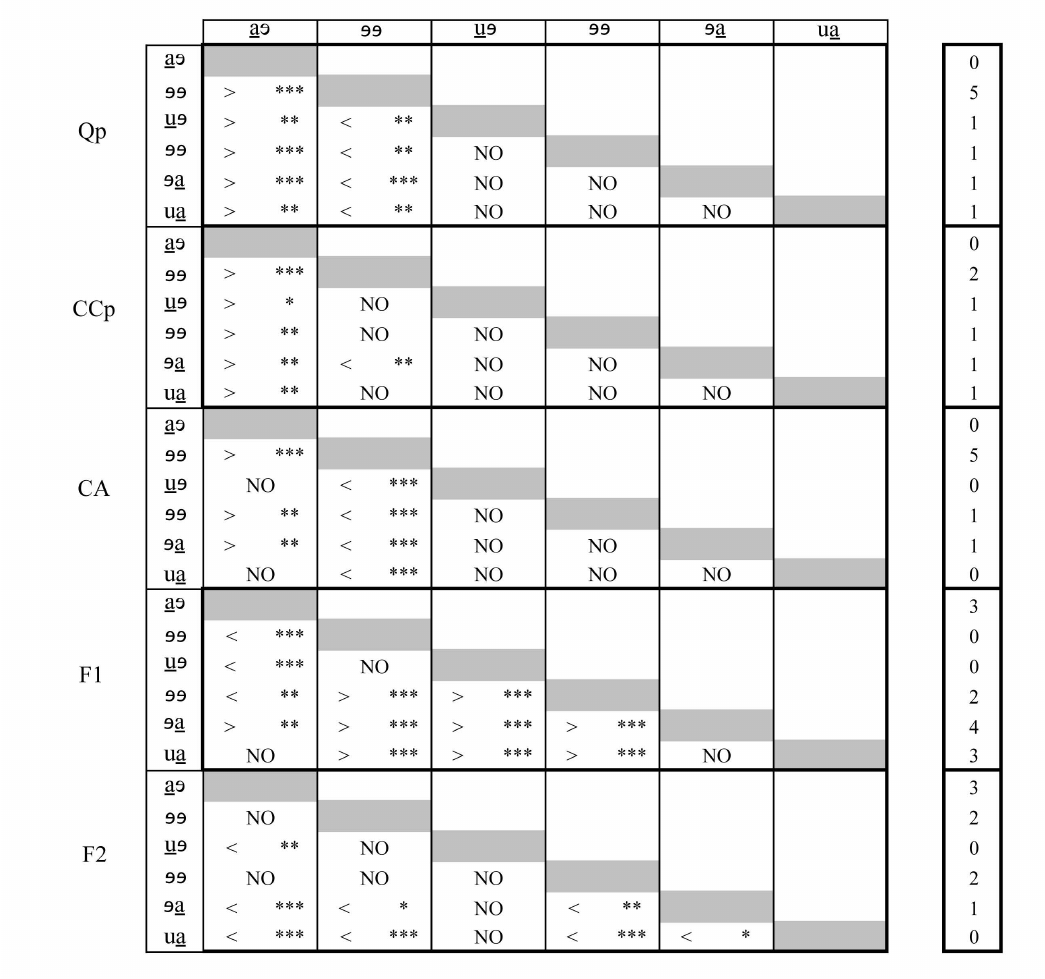
TABLE III. Significant Qp, CCp, CA, F1 and F2 differences for intervocalic [j] as a function of vowel context according to Bonferroni multiple comparisons tests. Stressed vowels in the VCV sequences appear underlined. Angles indicate that the vocalic sequences in the rows exhibit a higher (>) or a lower (<) value than the vocalic sequences in the columns. Asterisks correspond to the significance levels 0.05 (*), 0.01 (**), 0.001 (***). The rightmost column reports the number of times that a vowel sequence at a given row presents higher values than all other sequences under